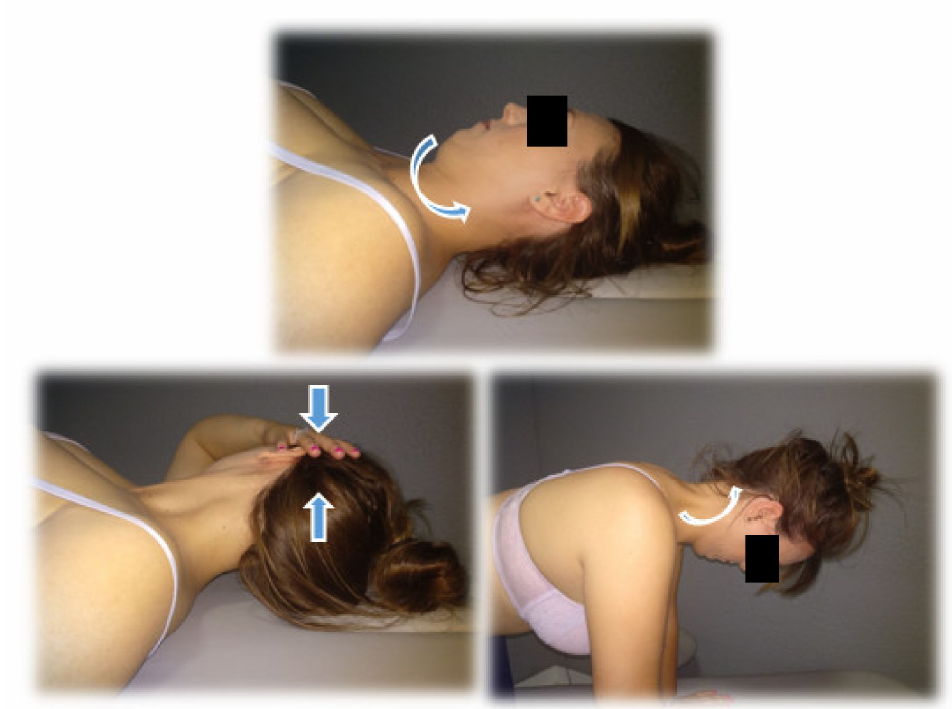
Figure 2. Examples of therapeutic